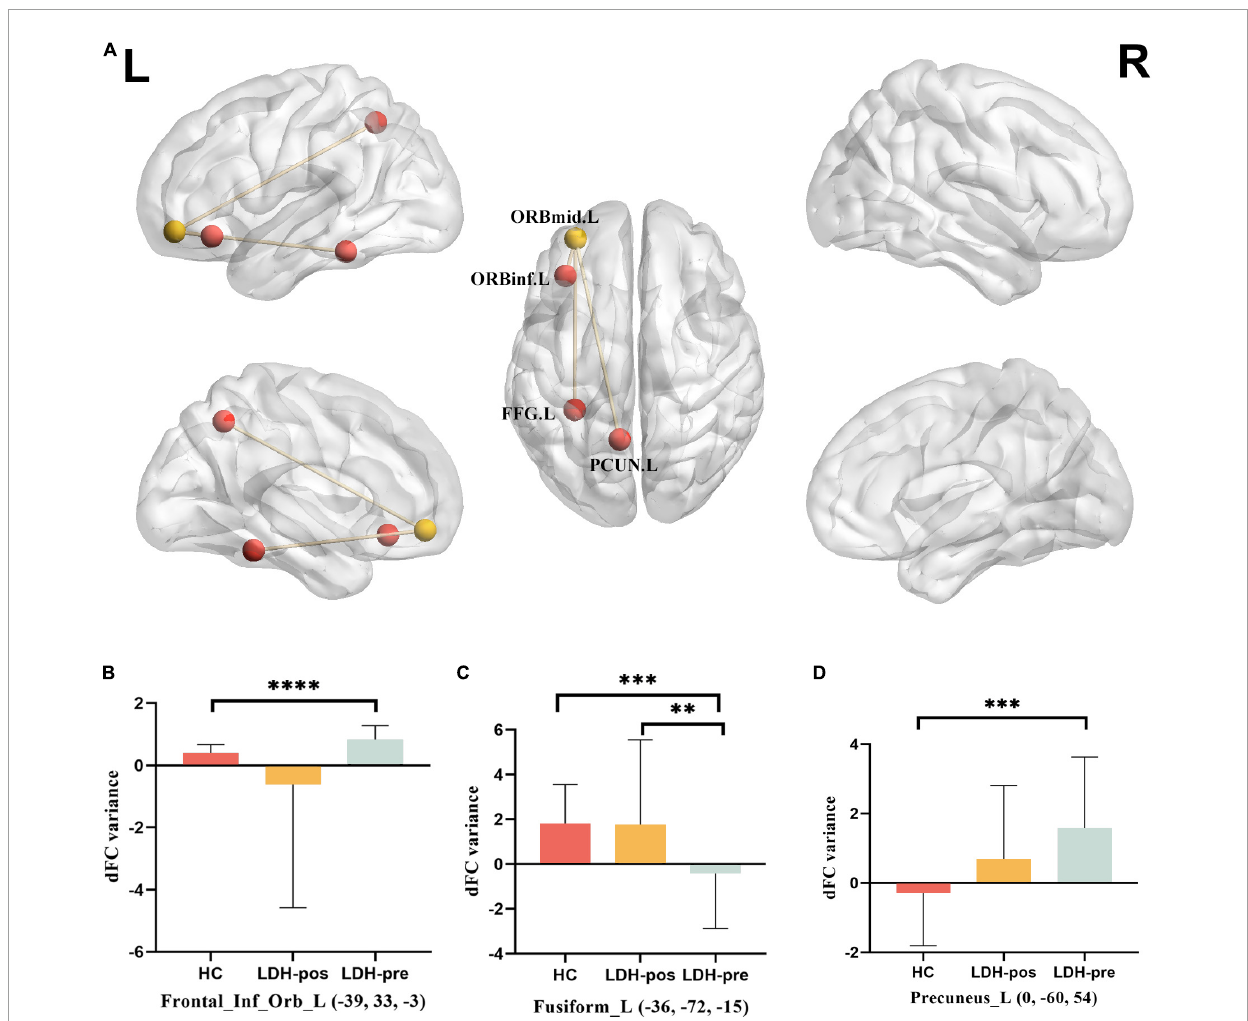
FIGURE3 (A) Brain regions showing group differences between LDH_pre and HCs in dynamic FC variance with the LO-MFG as seed. (B) DFC variance located in Frontal_Inf_Orb_L (compare each group with every other group). (C) DFC variance located in Frontal_Inf_Orb_L (compare each group with every other group). (D) DFC variance located in Precuneus_L (compare each group with every other group). The LDH patients and HCs were compared using two-sample t -tests, and LDH patients before and after Tuina were compared by paired t -tests. ∗∗ indicated significance level at p < 0.01 (two -tailed), ∗∗∗ indicated significance level at p < 0.001 (two -tailed), ∗∗∗∗ indicated significance level at p < 0.0001 (two -tailed). HC, healthy controls; LDH-pos, LDH patients after Tuina; LDH-pre, LDH patients before Tuina; LO-MFG, left orbital part middle frontal gyrus. Frontal_Inf_Orb_L, left orbital inferior frontal gyrus; Fusiform_L, left Fusiform; Precuneus_L, left